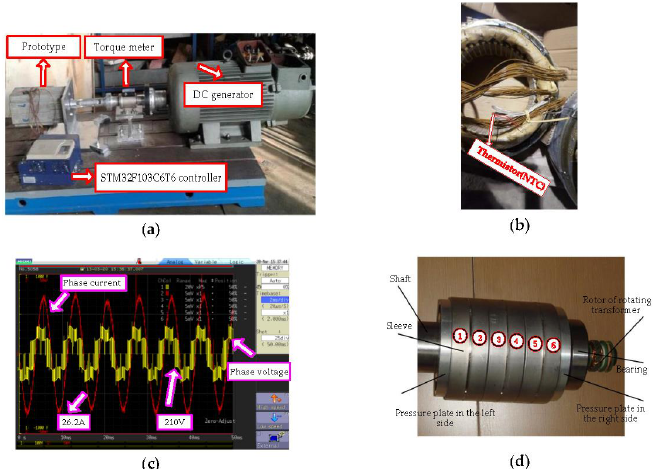
Figure 1. The experimental platform, results of calculation and experiment results, and rotor actual structure. ( a ) The experimental system; ( b ) The thermistor position in the winding; ( c ) Experiment results of phase current and voltage; ( d ) Rotor actual structure.